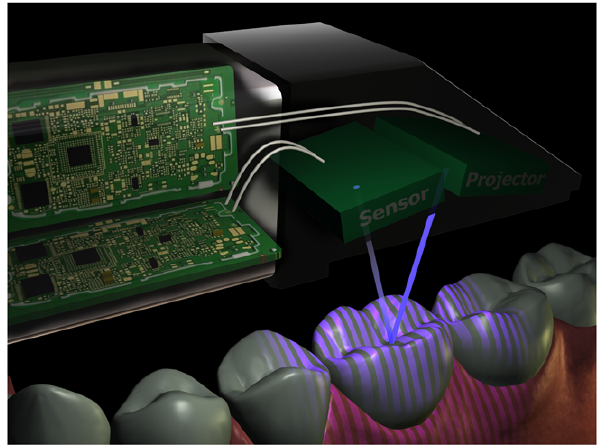
Figure 1. The technical principle of the CEREC scanner. The Cerec projects a light stripe pattern on the object. As each light ray is reflected back on the sensor, the distance between the projected ray and reflected ray is measured. Because the fixed angle between the projector and sensor is known, the distance to the object can be calculated through Pythagoras theorem, as one side and one angle (the fixed angle) of the triangle are now known. Hence the name